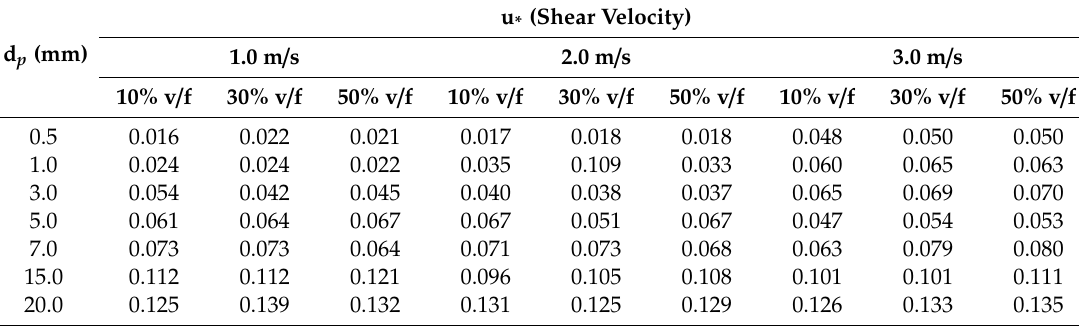
Table 4. Shear velocity results from two-phase flow